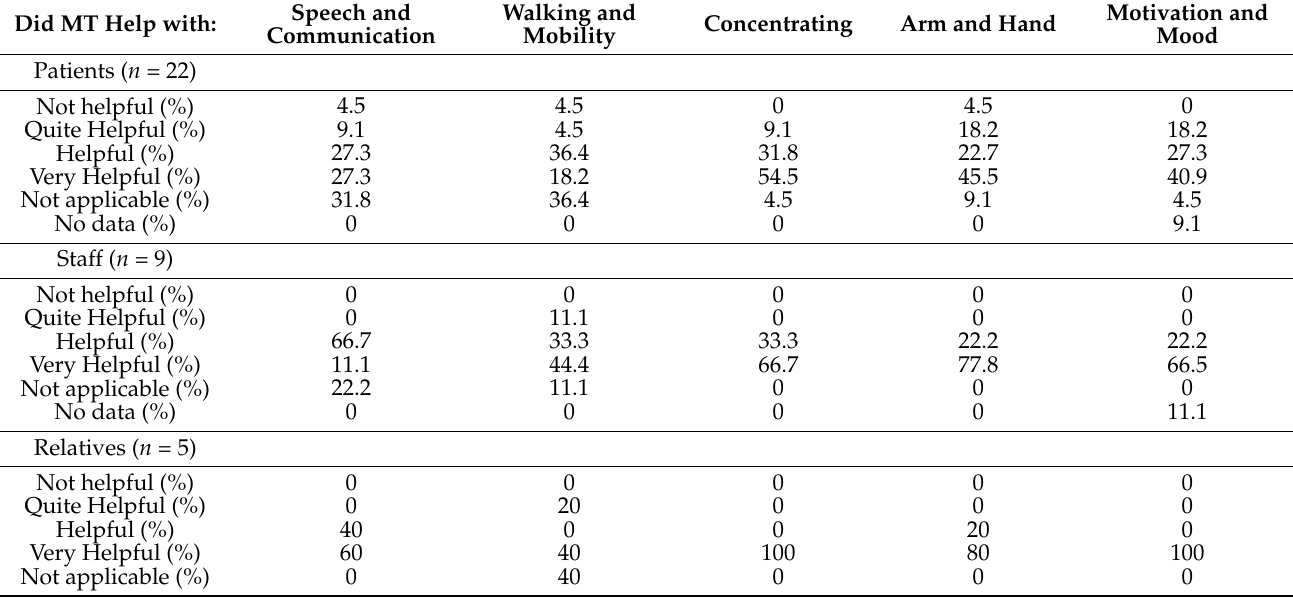
Table 3. Responses to the questions ‘What did music therapy help